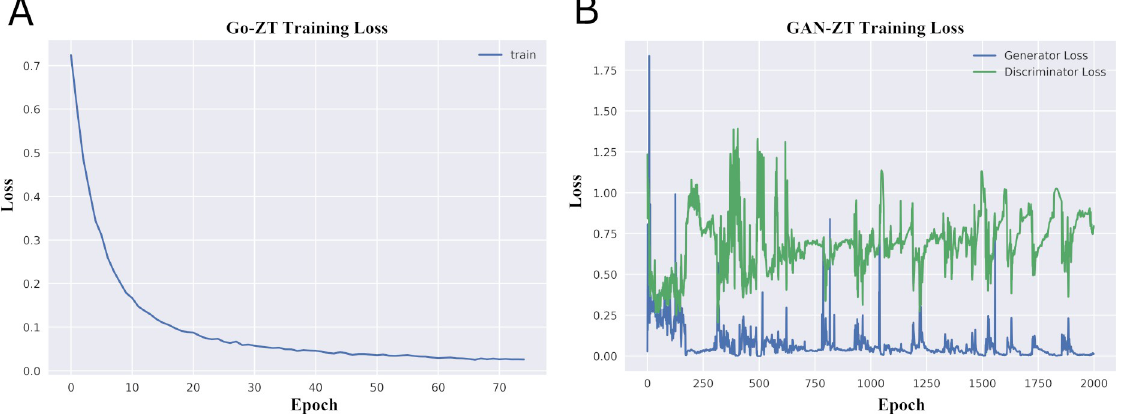
Fig 6. Go-ZT and GAN-ZT loss functions during training. Changes of loss functions during the training of (A) Go-ZT and (B) GAN-ZT.